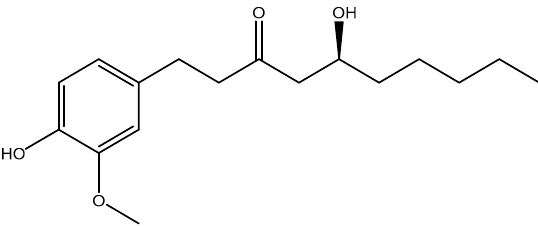
Figure 6. Chemical structure of